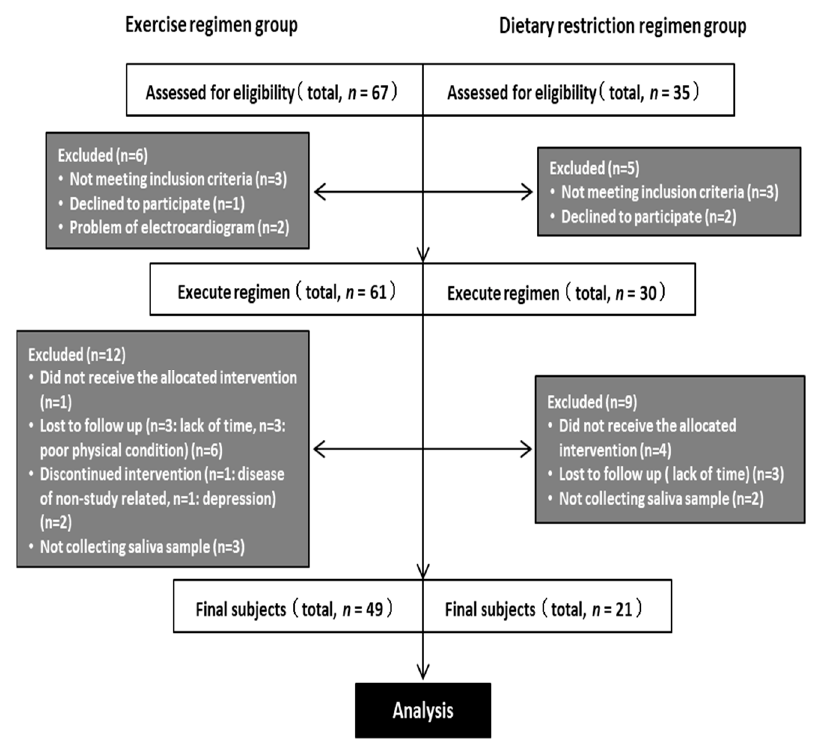
Figure 1. Flow chart for the study.